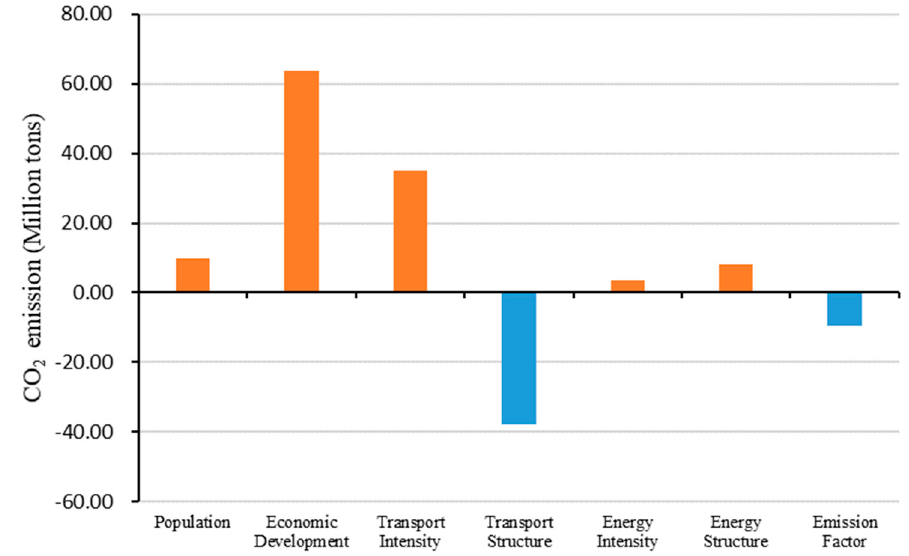
Figure 11. The cumulative contribution values of seven factors to the growth of CO 2 emissions within the Pearl River Delta.